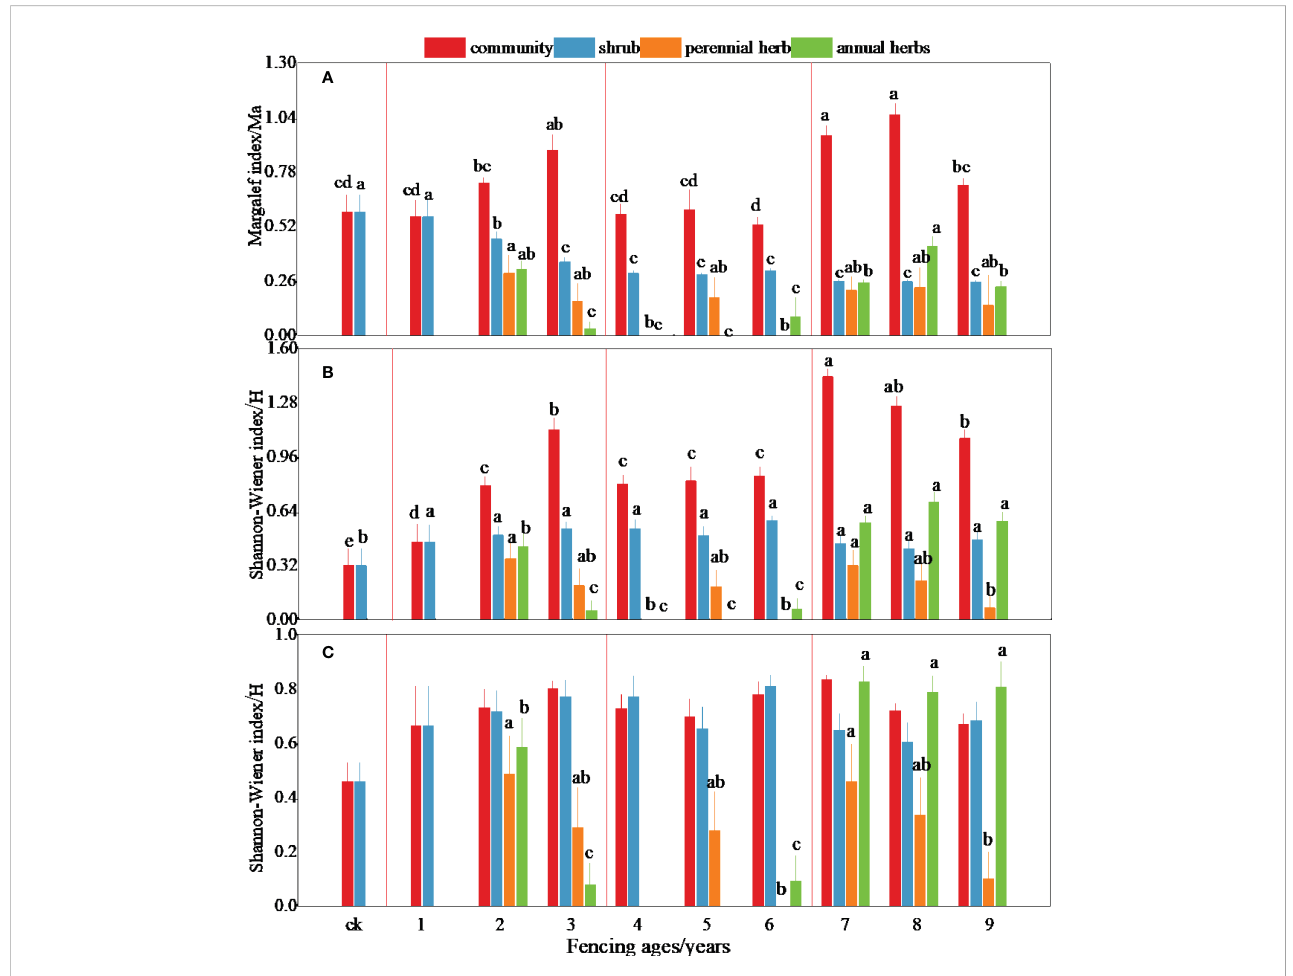
FIGURE 2 Dynamic changes of plant diversity in different fencing years. Different letters represent signi fi cant difference between different ages.